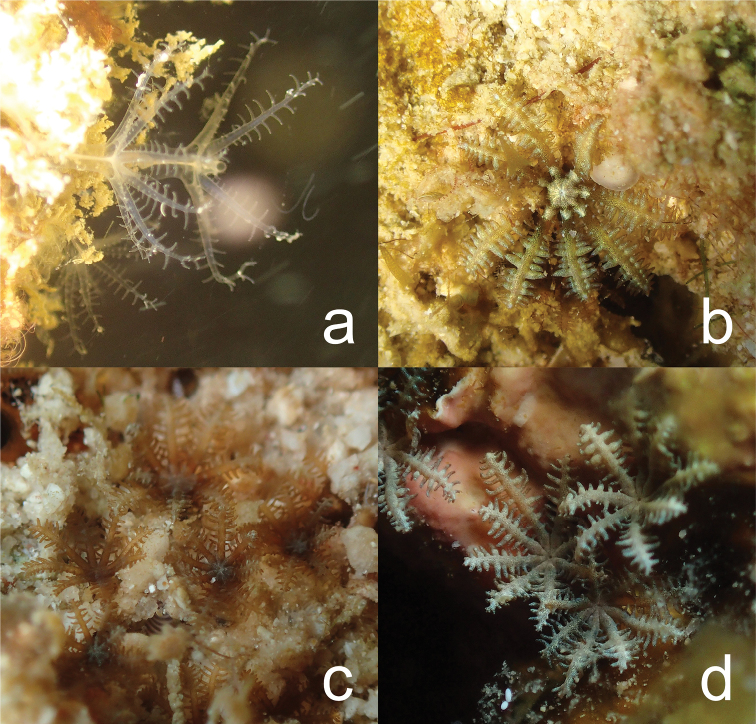
In situ photographs of clavulariids found in and around TARP, Kota Kinabalu, Sabah, Malaysia. aClavulariidae sp., specimen NSMT-Co 1686 bPhenganax
marumi sp. nov., holotype (NSMT-Co 1683) cPhenganax
subtilis sp. nov., holotype (NSMT-Co 1684) dPhenganax
stokvisi sp. nov., holotype (NSMT-Co 1685).